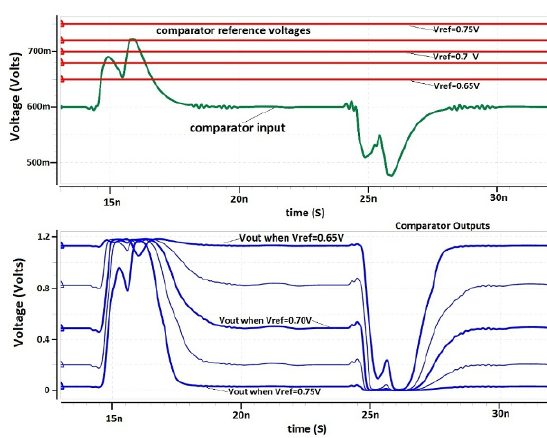
Figure 9. Dynamic behavior of the comparator (Frame 2) for a fixed reference voltage in response to an ideal output from the mixer (Frame 1).